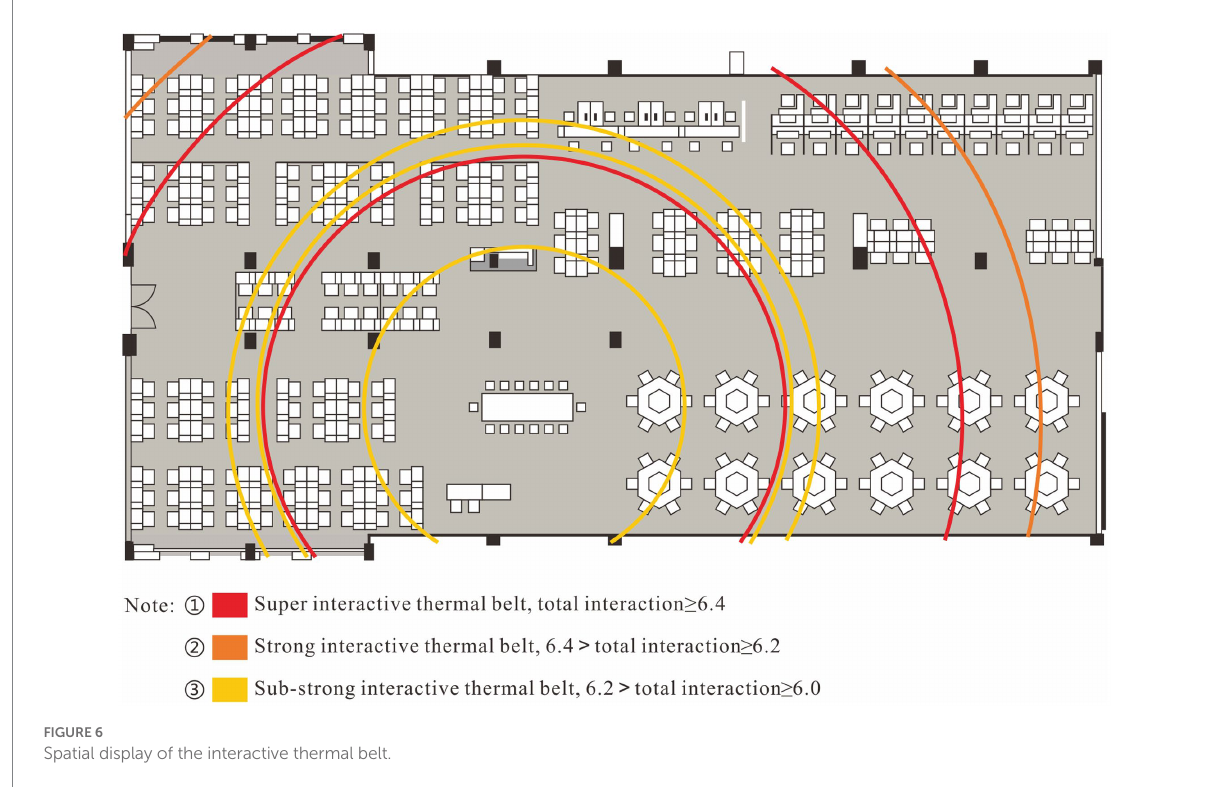
FIGURE 6 Spatial display of the interactive thermal belt.